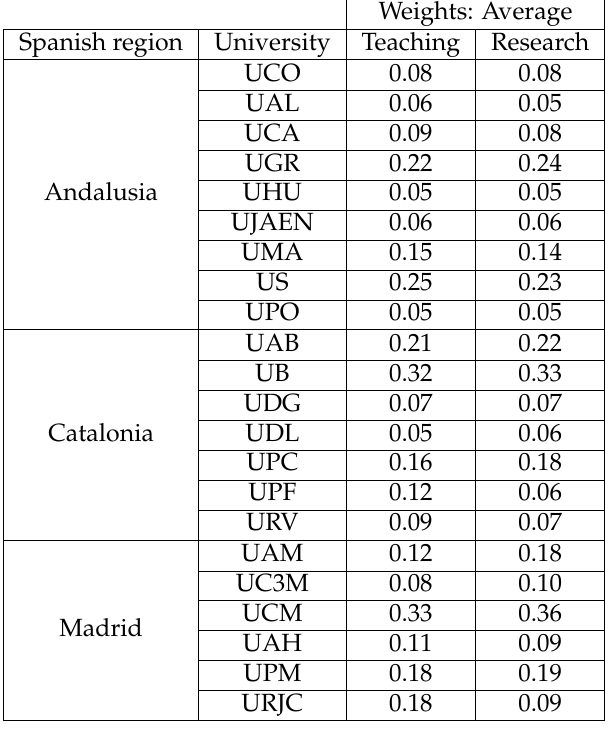
Figure A2. The average of the weights of the five academic years used for the WWCI by